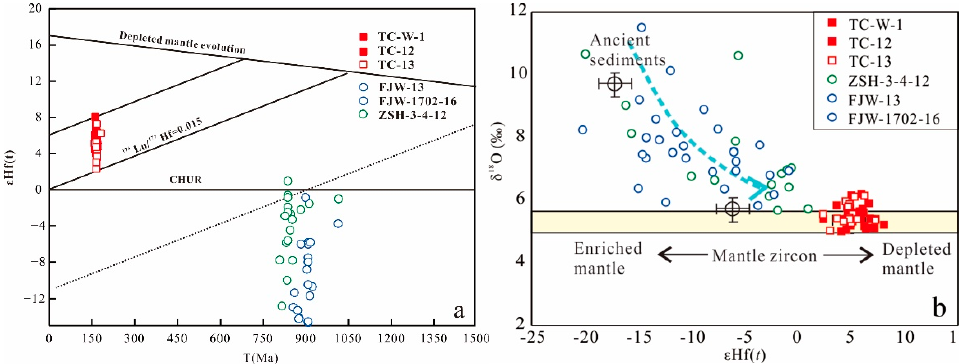
Figure 5. ( a ) Zircon Hf isotope composition of the Dexing porphyry copper deposit indicating different sources from the wall rocks; ( b ) plot of in situ zircon ε Hf( t ) vs. δ 18 O values for the Dexing porphyry and wall rocks.